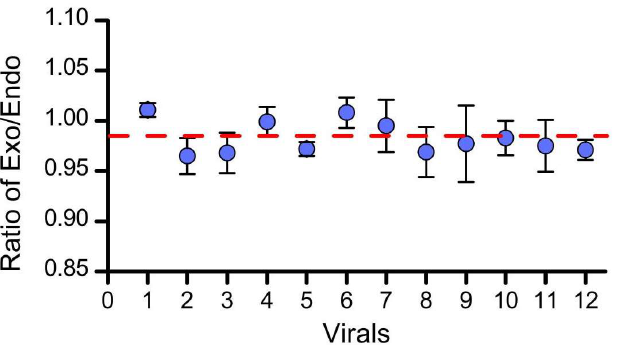
Figure 1. Schematic diagram of homogeneity test results. Error bars represent the standard error of the corresponding vials. Table 3. Results of the homogeneity study.